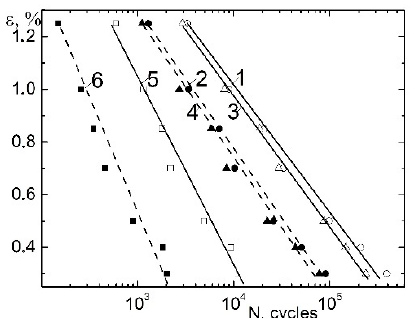
Figure 17. Curves of low-cycle fatigue (number of cycles before failure—load amplitude) of samples of the steels 25H2NMFA (1,2) and 20H3NMFA (3,4) and their welded joint (5,6) in air (1,3,5) and hydrogen at a pressure of 10 MPa (2,4,6).